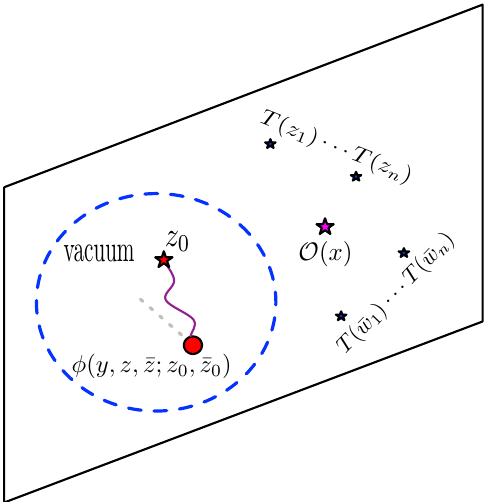
Figure 1 . This (cid:12)gure suggests many aspects of our reconstruction strategy. We reconstruct a bulk operator (cid:30) connected by a Wilson line or ‘gravitational dressing’ that attaches to the boundary at z 0 . Correlators of (cid:30) with stress tensors will only have singularities when the stress tensors approach z 0 . When (cid:30) acts on the vacuum, it creates a state that we expand in radial quantization, and so when we de(cid:12)ne (cid:30) we assume it is surrounded by empty space. As our methods are ultimately based on symmetry, we only compute the proto-(cid:12)eld (cid:30) as a linear combination of a CFT 2 primary and O its Virasoro descendants. All of these statements have analogs for the U(1) charged (cid:30) we discuss as a warm-up in section 2, with T J !